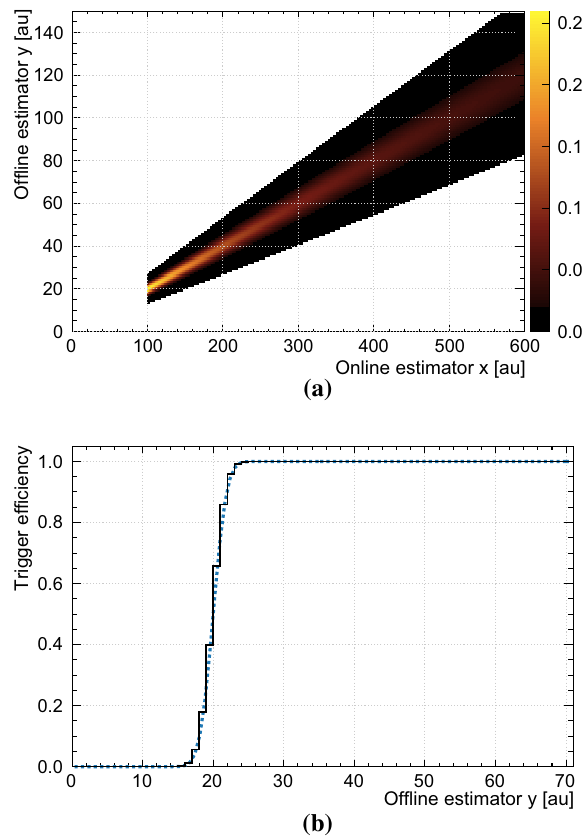
Fig. 4 The Gaussian example with μ = 0 . 2 y and σ = 0 . 015 y . a x